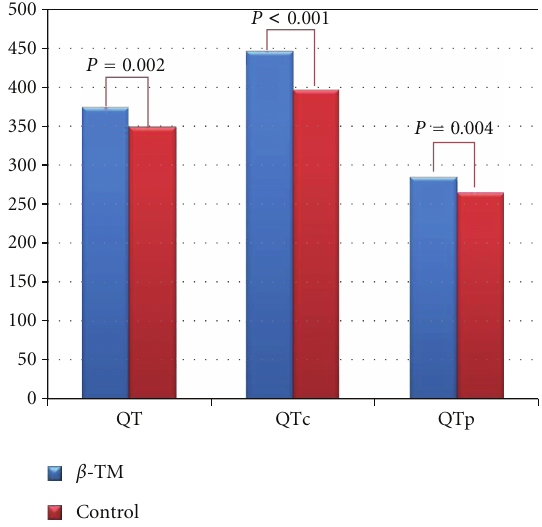
Figure 2: A comparison of QT, QTc, and QTp in patients with β - TM and healthy controls.